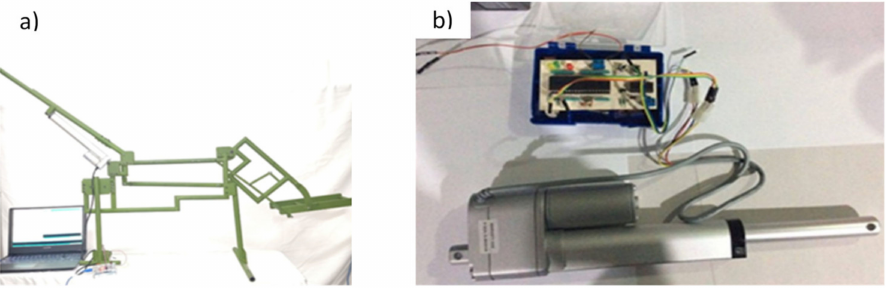
Figure 14. Experimental wheelchair position test; ( a ) Wheelchair prototype ( b ) Electronic